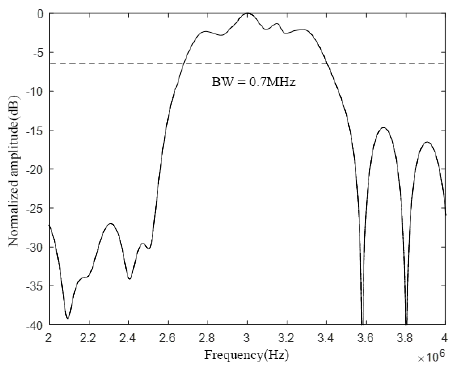
Figure 12. CMUT bandwidth composed of five cell sizes.